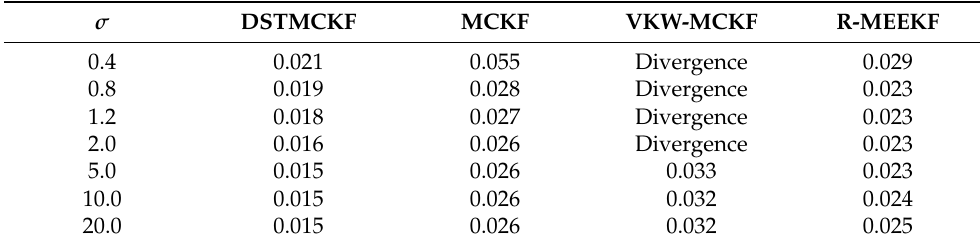
Table 2. RMSE (m) with different σ (Case 1).